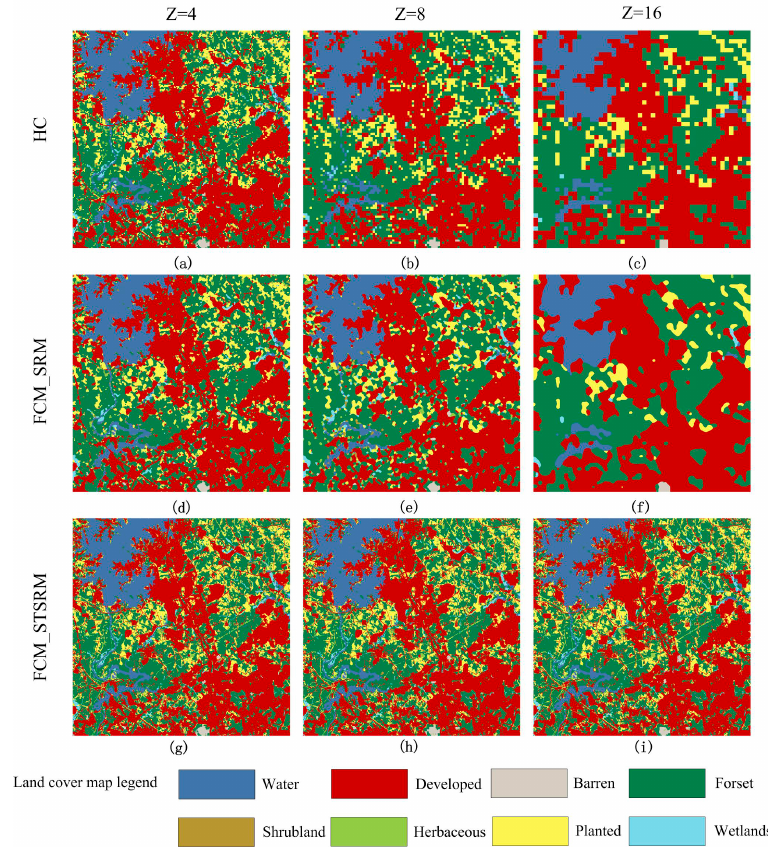
Figure 6. Resultant land cover maps generated by the three different methods with different zoom factors: ( a ) HC (z = 4); ( b ) HC (z = 8); ( c ) HC (z = 16); ( d ) FCM_SRM (z = 4); ( e ) FCM_SRM (z = 8); ( f ) FCM_SRM (z = 16); ( g ) FCM_STSRM (z = 4); ( h ) FCM_STSRM (z = 8); and ( i ) FCM_STSRM (z =